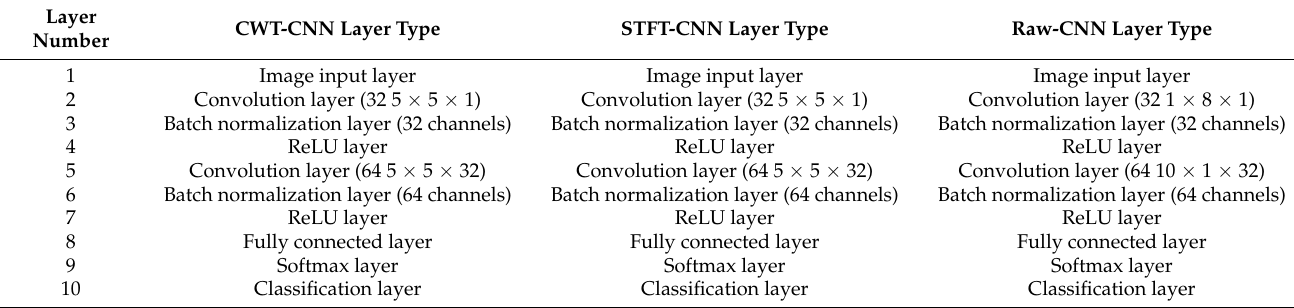
Table 1. The framework of CNNs